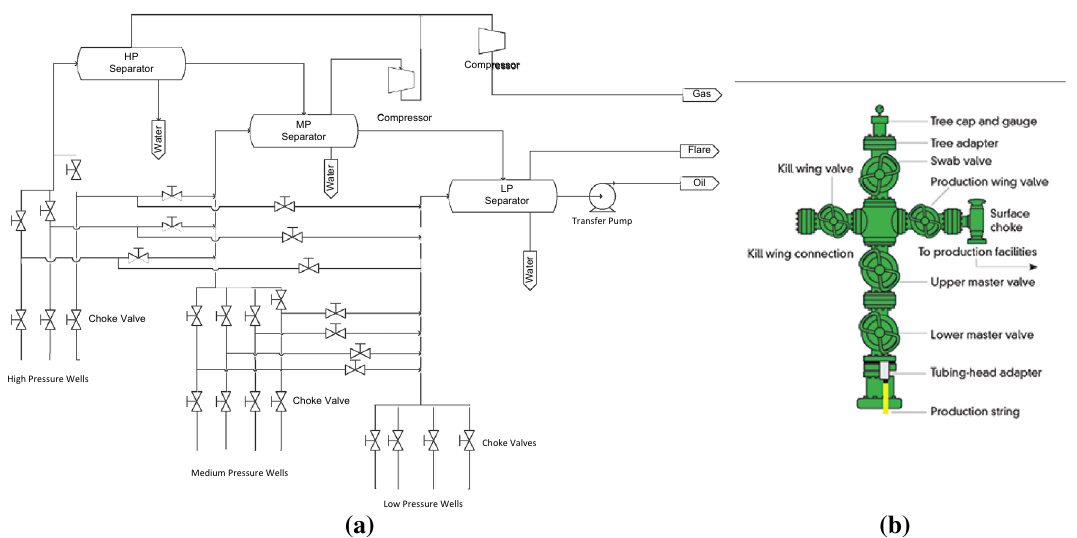
Fig. 1 a Typical subsurface and surface connections and b typical surface choke valve in a Christmas tree (Izadmehr et al.